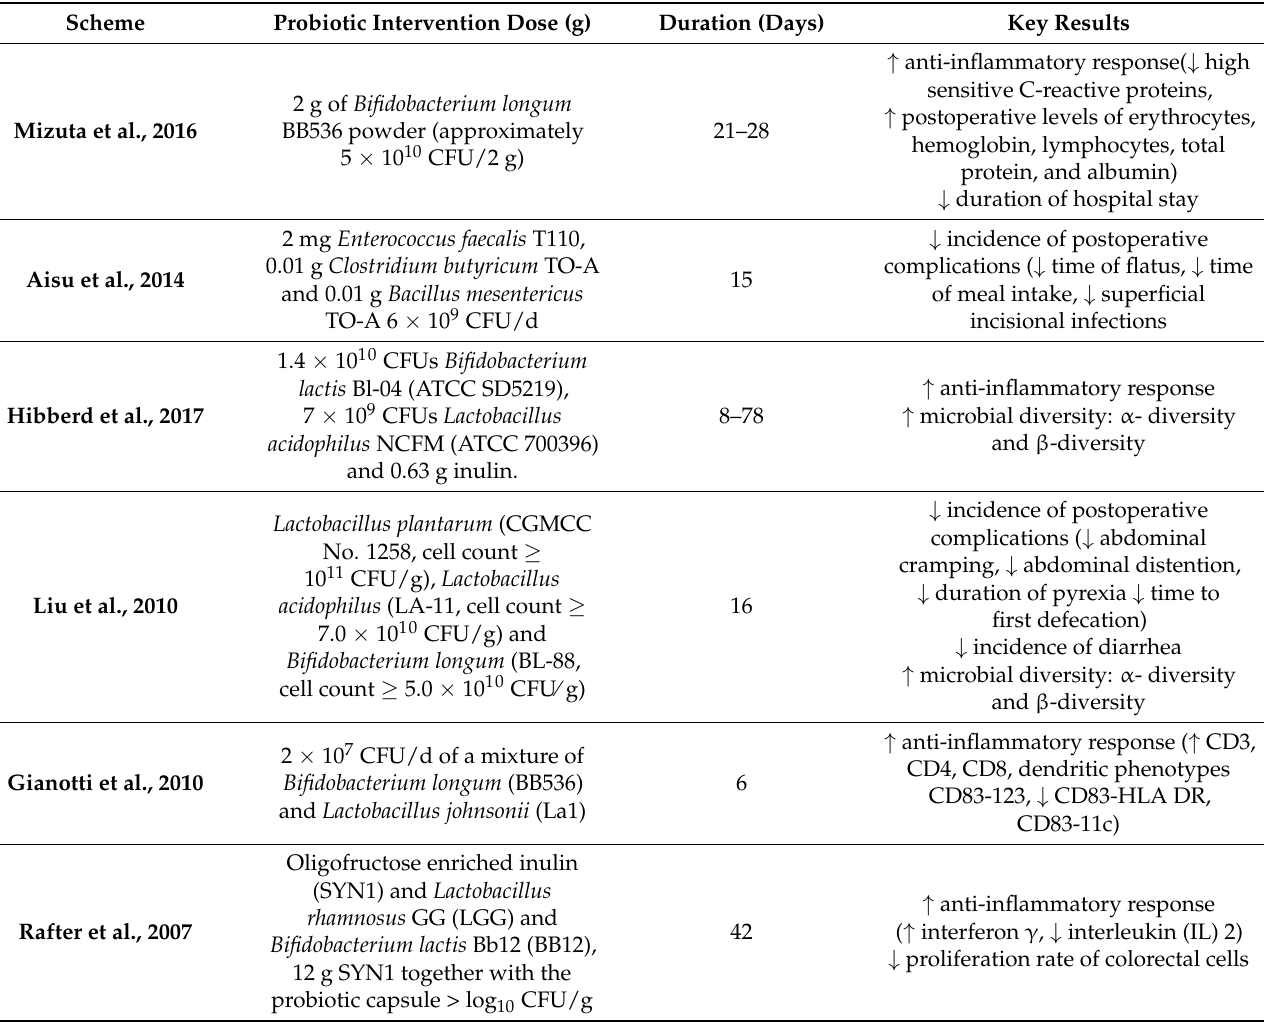
Table 2. Probiotic supplementation and CRC: outcomes of clinical